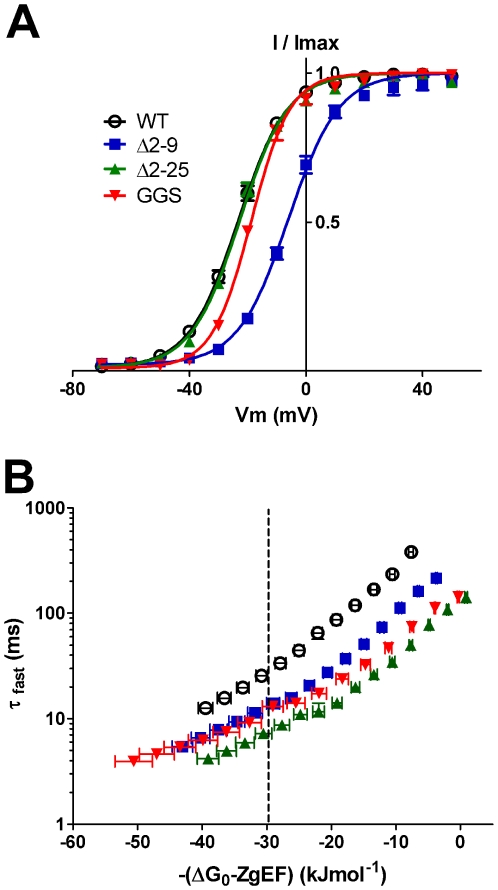
Rates of deactivation after correction for changes in activation properties.Steady–state activation curves for WT (open circles, n = 11), Δ2–9 (blue squares, n = 14), Δ2–25 (green triangles, n = 5) and GGS (red inverted triangles, n = 10) channels are shown in panel A. Peak tail currents recorded at −70 mV, following steps to a range of potentials between −70 mV to +50 mV, were normalized to Imax and plotted against the preceding voltage. Data represented as mean ± SEM were fitted with Boltzmann expression (solid lines, see Methods). Construct Δ2–9 gave channels exhibiting a shift in the half maximal voltage for activation (V
0.5) in the depolarizing direction compared to WT hERG. B. Rates of deactivation (τ
fast from Fig. 3C) are plotted against the total electrochemical driving force –(ΔG0–z
g
EF) for channel deactivation. Deactivation rates taken at an equivalent driving force of −30 kJmol–1 (dotted line) indicate that all mutant channels deactivate faster than WT hERG (symbols as in A).